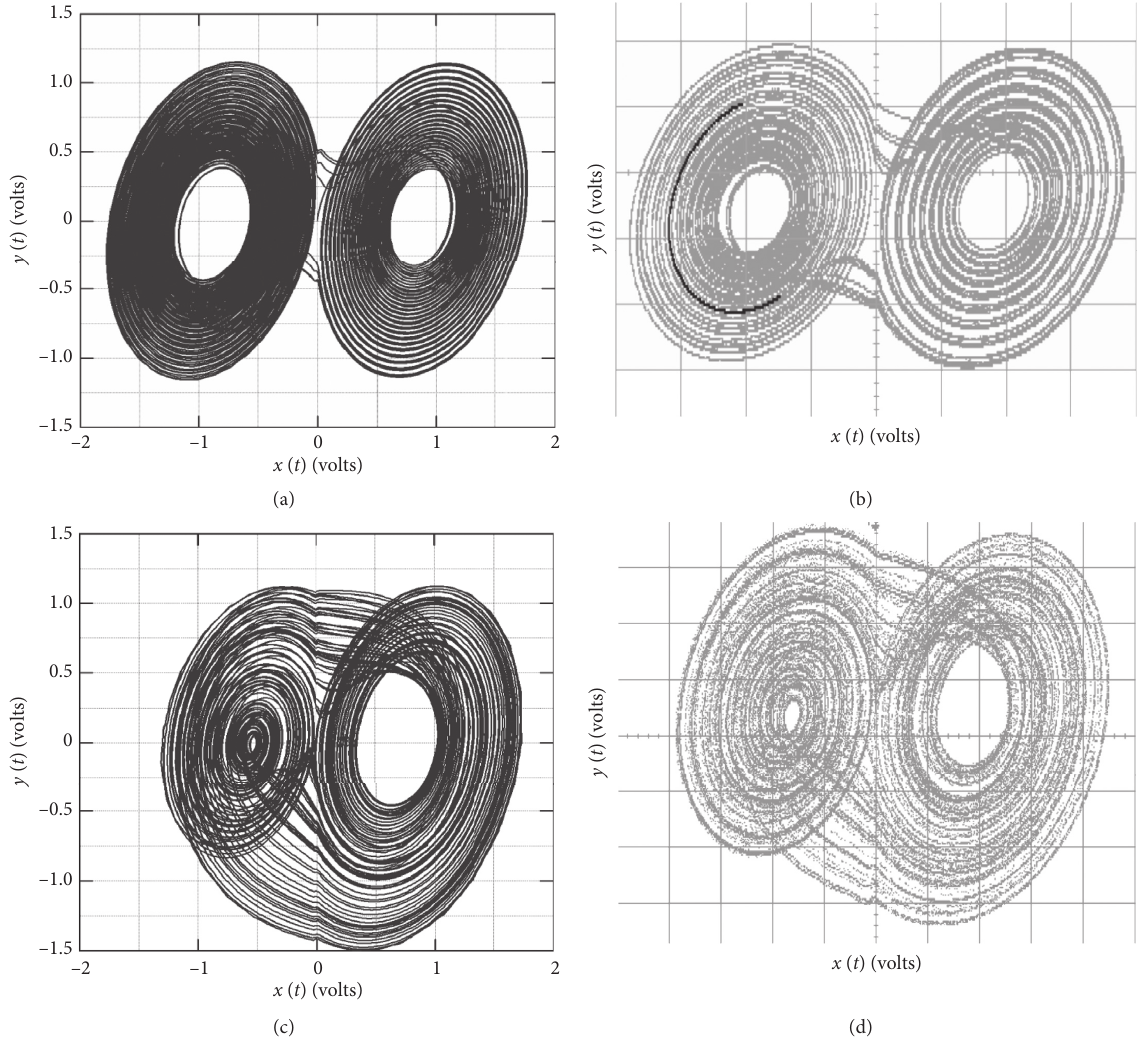
Figure 12: Projection of the 2-scroll chaotic attractor onto xy -plane (phase space portrait): (a) simulation result with α � 0 . 9 (SPICE); (b) experimental result with α � 0 . 9 (oscilloscope scale � 0.5V per division); (c) simulation result with α � 0 . 95 (SPICE); (d) experimental result with α � 0 . 95 (oscilloscope scale � 0.3 V per